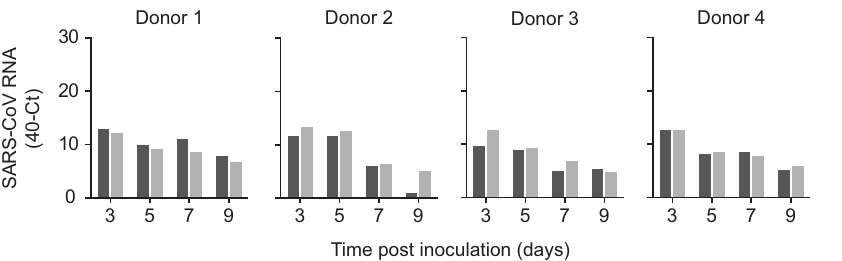
Fig. 5 Detection of SARS-CoV RNA on the fur of donor ferrets. SARS-CoV RNA was detected by qRT-PCR in swabs collected from the fur on the left (dark gray) and right (light gray) fl ank of all four donor ferrets. An infectious virus was not detected in